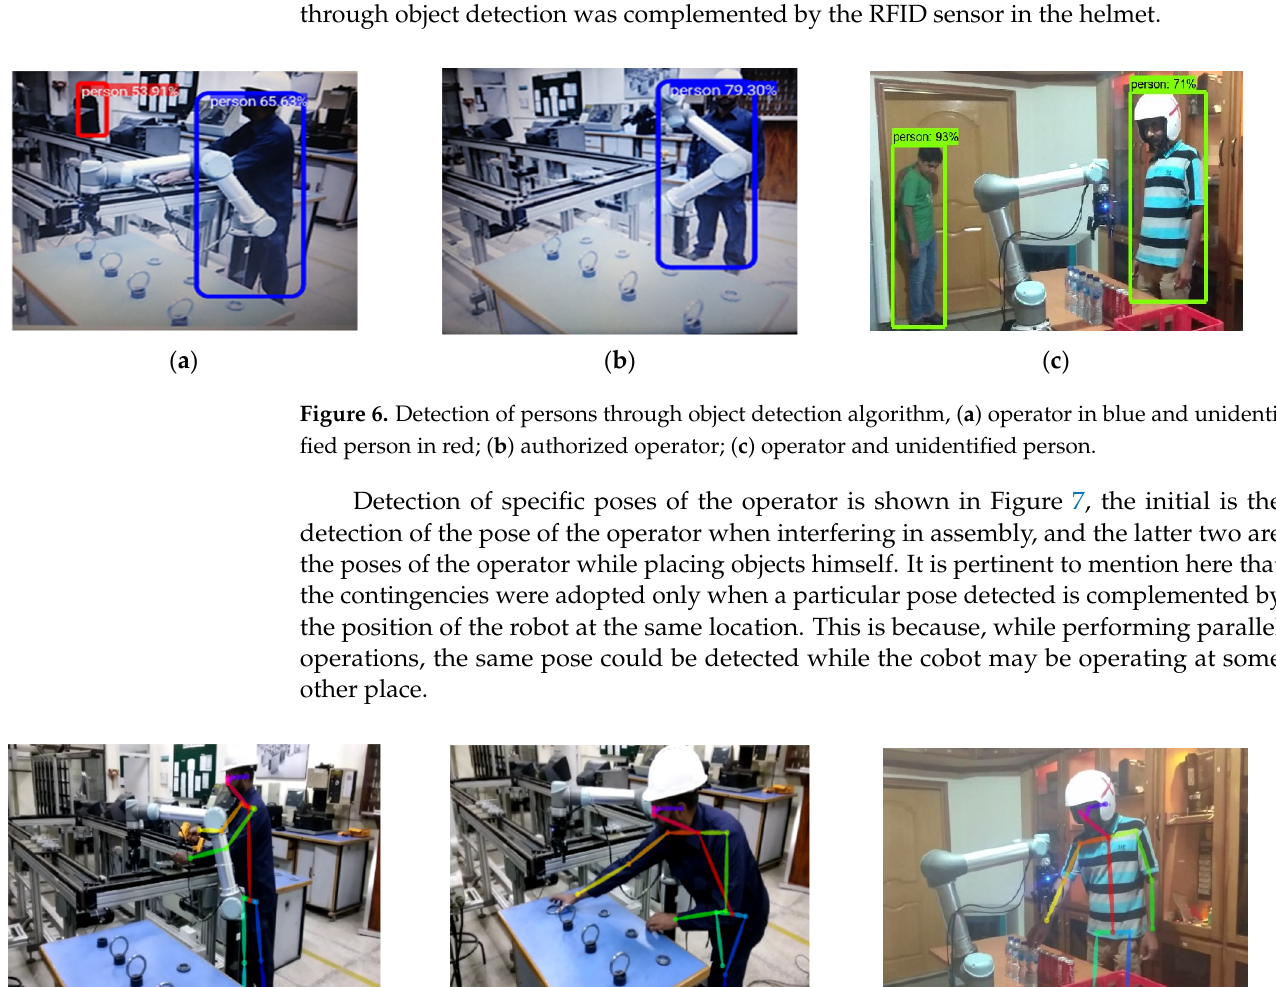
Figure 5. Detection of objects through object detection algorithm, ( a ) gear 1; ( b ) gear 2; ( c ) bottles; ( d ) cans.